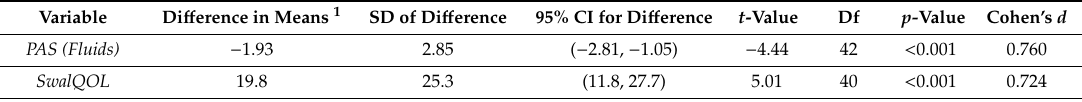
Table 8. Parameters from paired-samples testing: all patients.